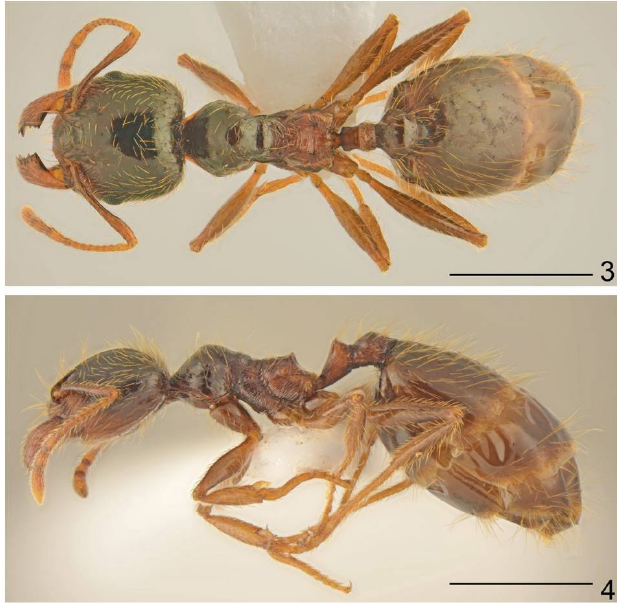
Figs 3-4 . Dark worker of teratological form “ symbiotica ” of Pheidole pallidula . 3. Dorsal; 4. Lateral. Scale bar = 1